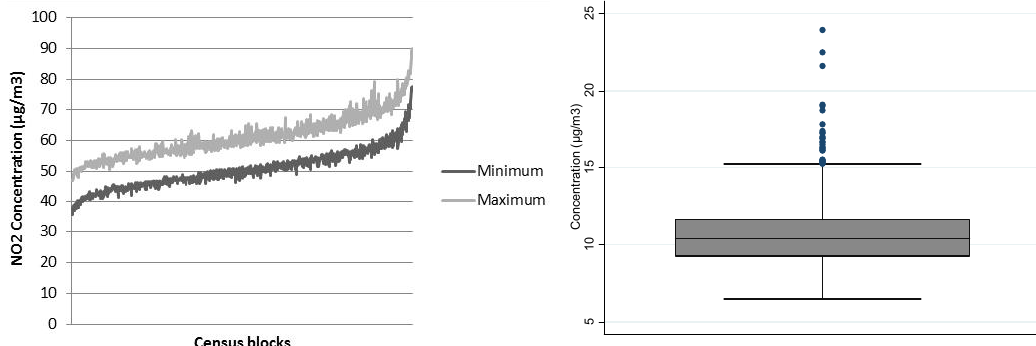
Figure 4. Distribution of intra-census block variability (difference between maximum and minimum of NO 2 concentrations at the census block level (in µg/m 3 )) for the entire study period from 2002 to 2012. Box plots of the difference between the maximum and the minimum (fifth percentile, first quartile, median, third quartile, ninety-fifth percentile).